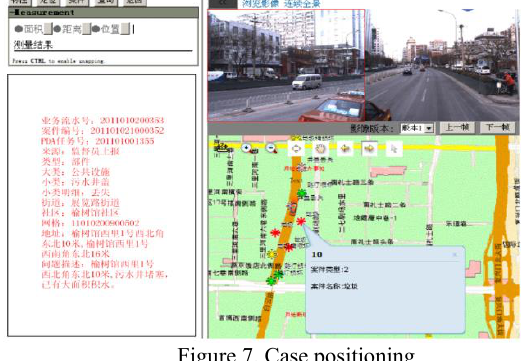
Figure 7. Case positioning